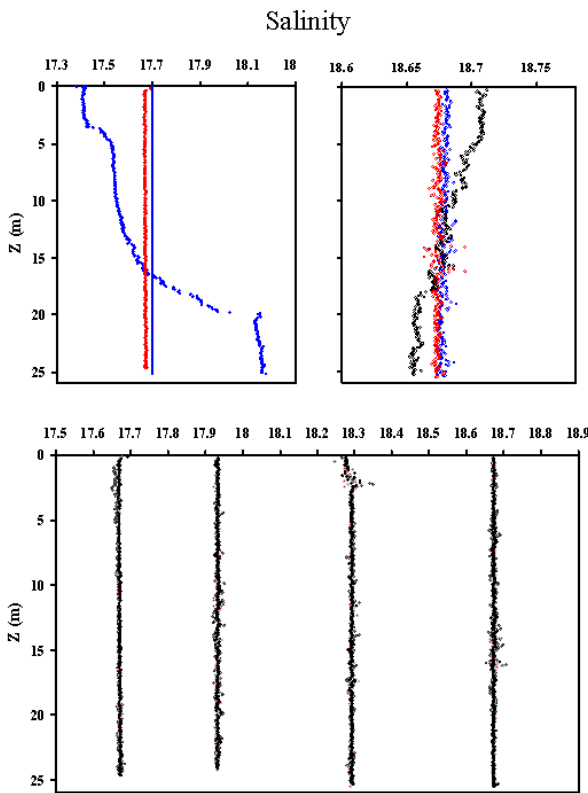
Fig. 2. (a) A natural vertical salinity profile in a 25-m-deep meso- cosm (blue dots). The average salinity of the profile is indicated by a vertical blue line. Red dots are salinity measurements after mixing the water column using 5-min bubbling with compressed air. Differ- ences are caused by the uneven shape of the bag (here especially the bottom funnel) (b) The black profile is collected right after inject- ing salt brine to the upper 22m of the mesocosm, the blue profile is measured 6h later and the red profile 18h later. (c) Homogeneous S profile shown in (a) is increased in three steps, measured on three consecutive days using three replicated profiles shown as black, red and gray dots.